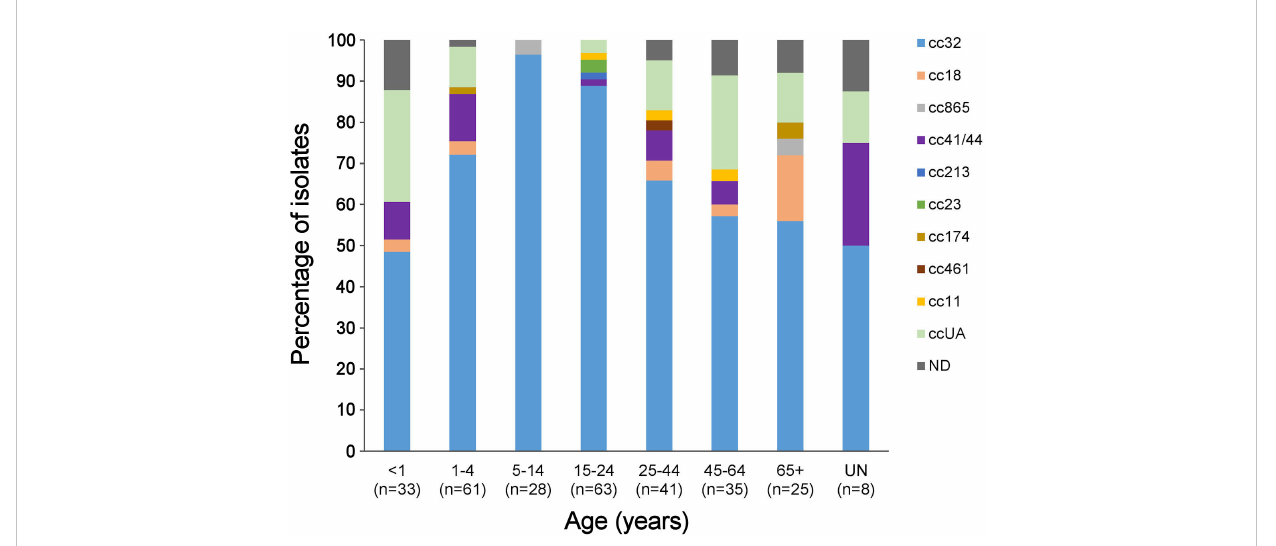
FIGURE 2 Distribution of clonal complexes according to age. ND, no age information of IMD cases (n=8); ccUA, sequence type not assigned to any cc; cc, clonal complex; n, number of